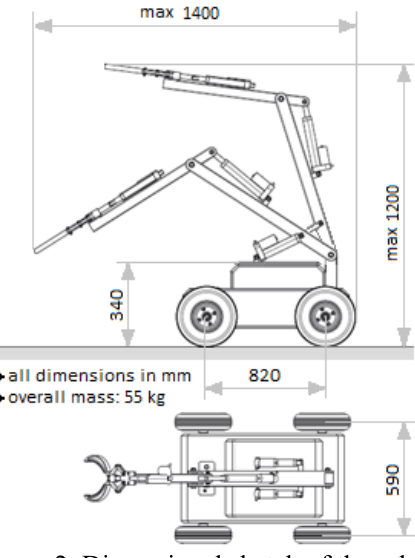
Figure 2. Dimensional sketch of the